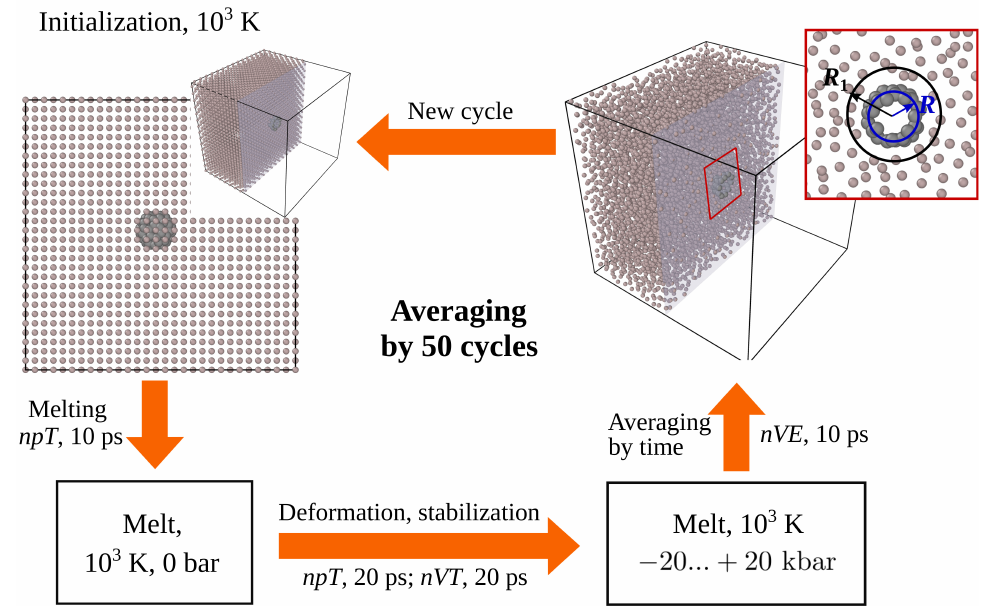
Figure 1. Schematic of the MD simulation